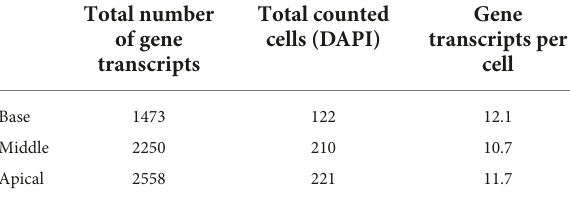
TABLE 3 Quantification of GJB2 gene transcripts in the lateral wall of the three turns in a human cochlear